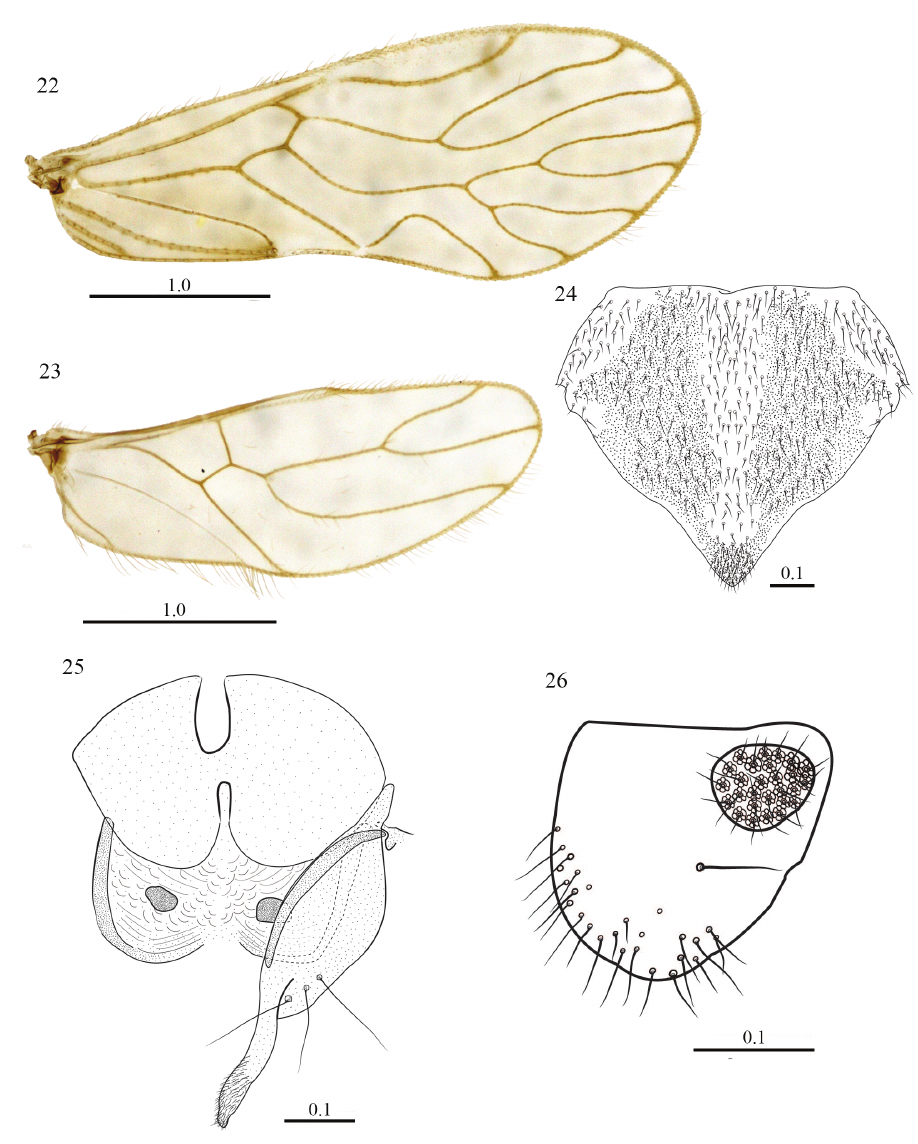
Figures 22–26. Triplocania lamasoides sp. n. (Paratype female). 22 Forewing 23 Hindwing 24 Subgenital plate 25 Gonapophyses and Ninth sternum 26 Left paraproct Scales in mm. margin. Hindwing Rs almost straight. Hypandrium (Fig. 19) of four sclerites, ante- rior piece broad, setose, bearing distally two sickle-shaped lateral projections, heavily sclerotized at both ends, and having also a well defined, setose sclerotized area in the middle; posterior sclerite concave anteriorly, with a long, slender posterior projec- tion in the middle, flanked by two large, broadly triangular lateral sclerites.